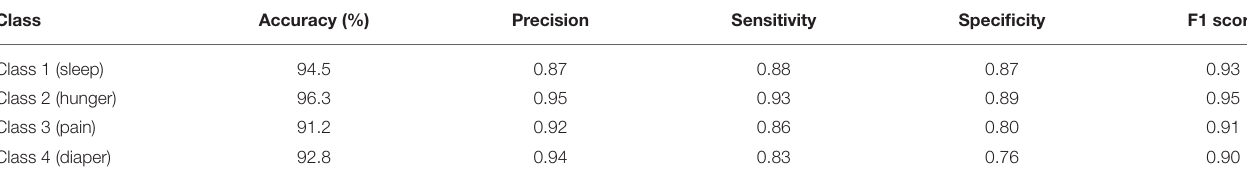
TABLE 15 | Multistage heterogeneous stacking ensemble classification model 2.